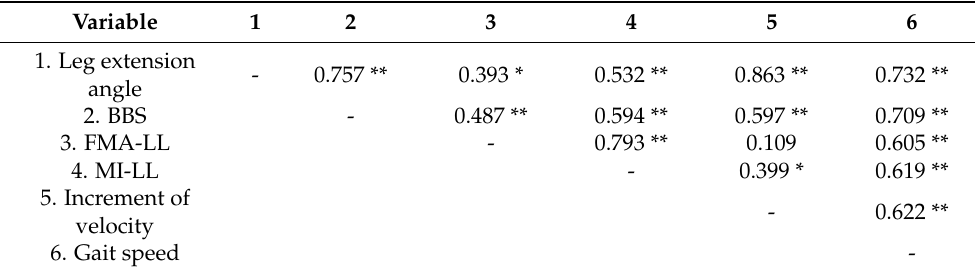
Table 2. Correlations among leg extension angle, physical impairments, and gait parameters on the affected side.